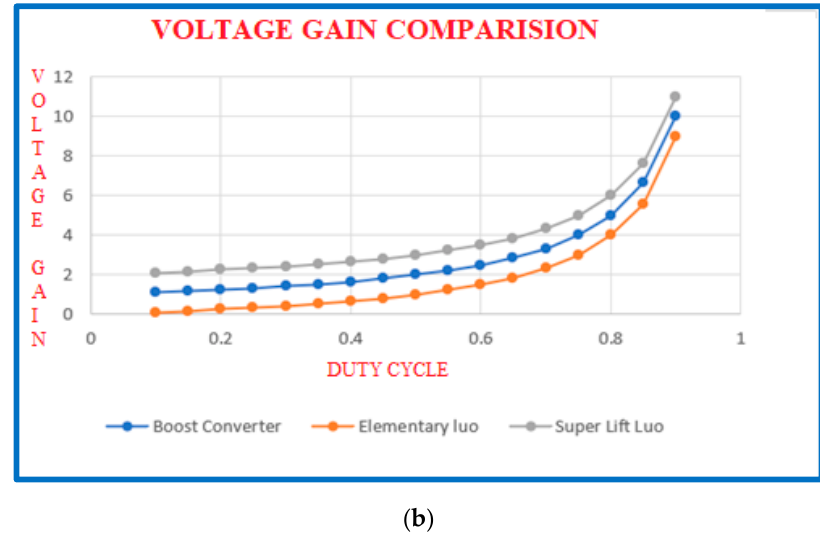
Figure 3. ( a ) Efficiency of three converters; ( b ) voltage gain of three converters.